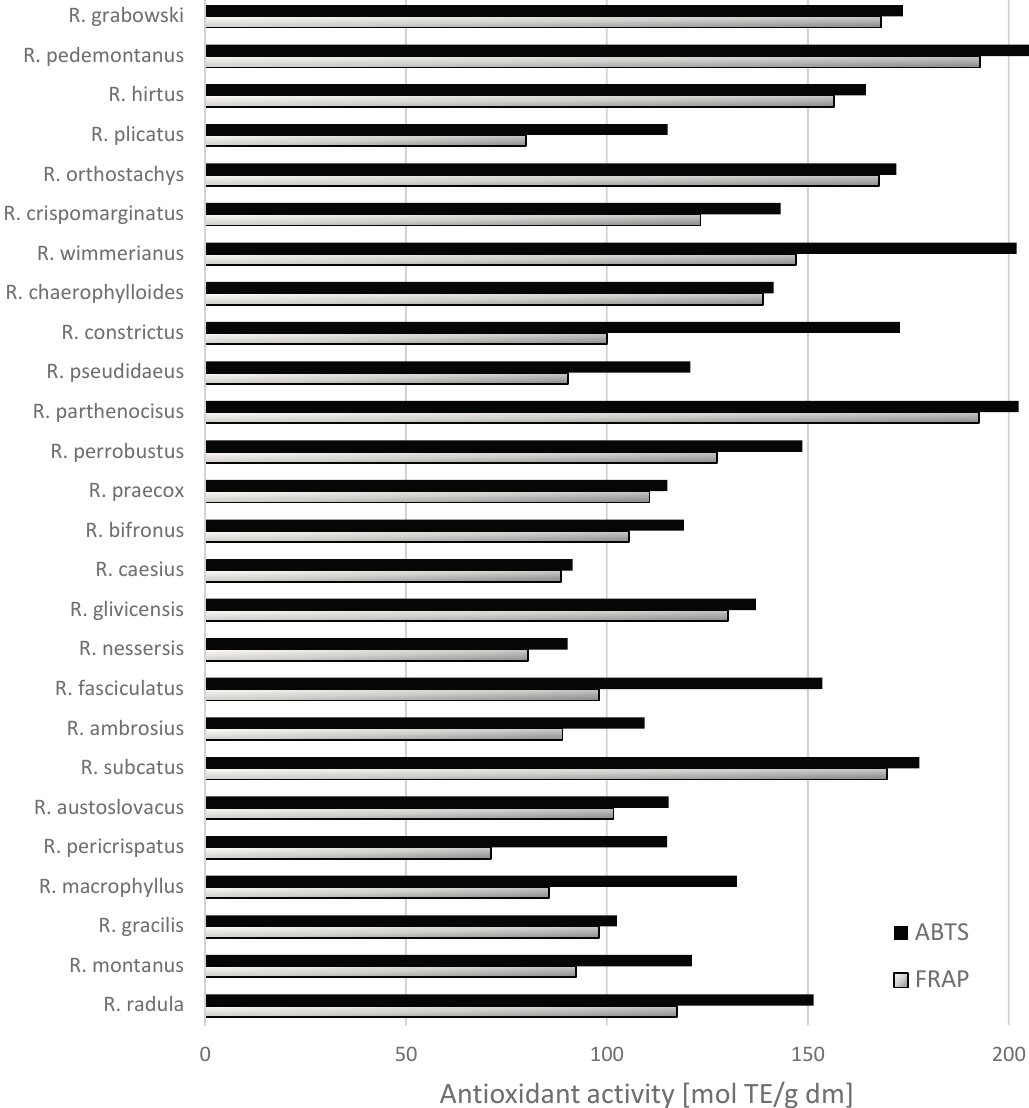
Figure 2. Antioxidant activity evaluated as ABTS °+ and FRAP in leaves [mmol TE/g] from wild Rubus L.